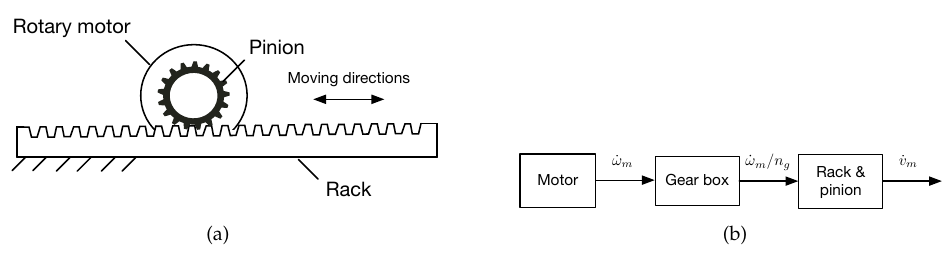
Figure 1. Feed drives of the rack and pinion: ( a ) schematic diagram; ( b ) block diagram.